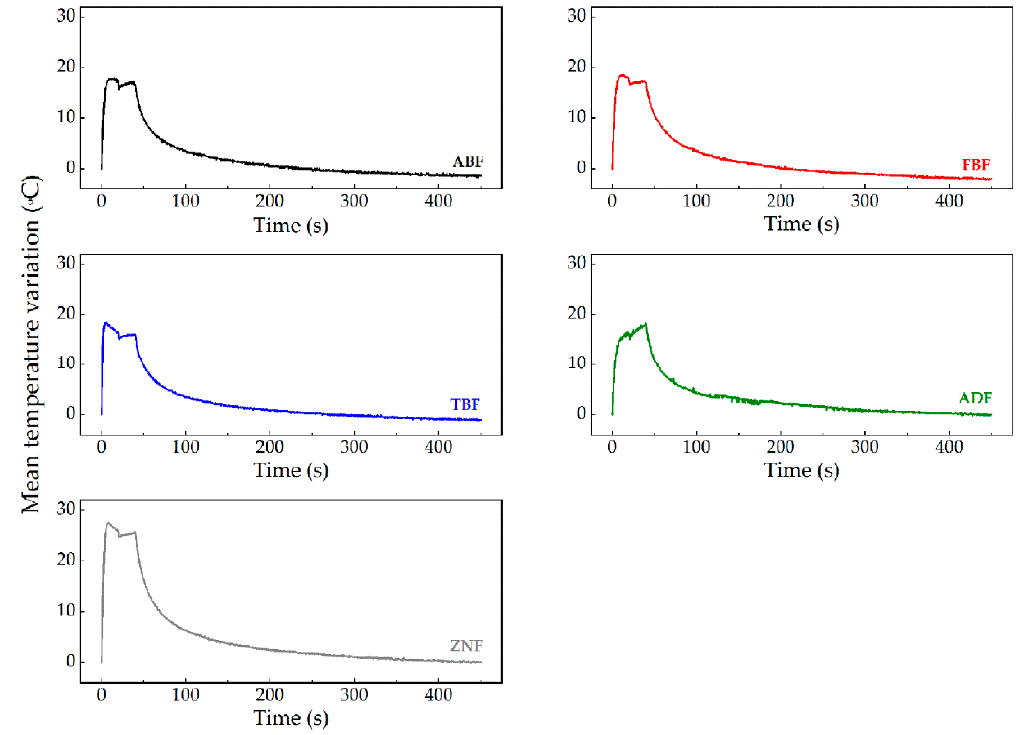
Figure 2. Mean temperature variation induced during the light curing of the RBCs.